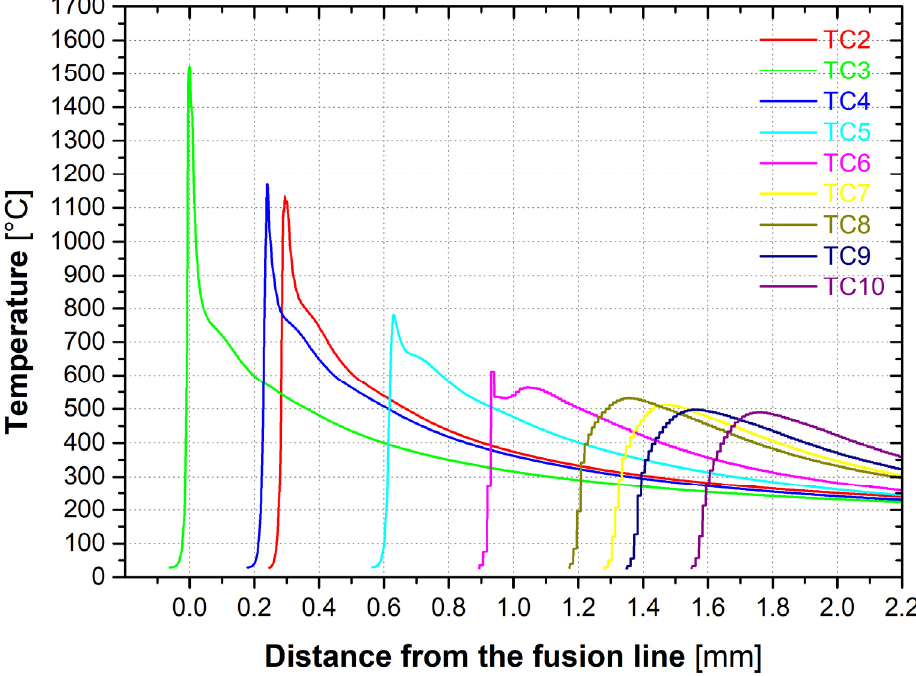
Figure 11. Temperature cycles (offset to correspond the actual distance from the fusion line)—heat input value 14 kJ·cm − 1 .